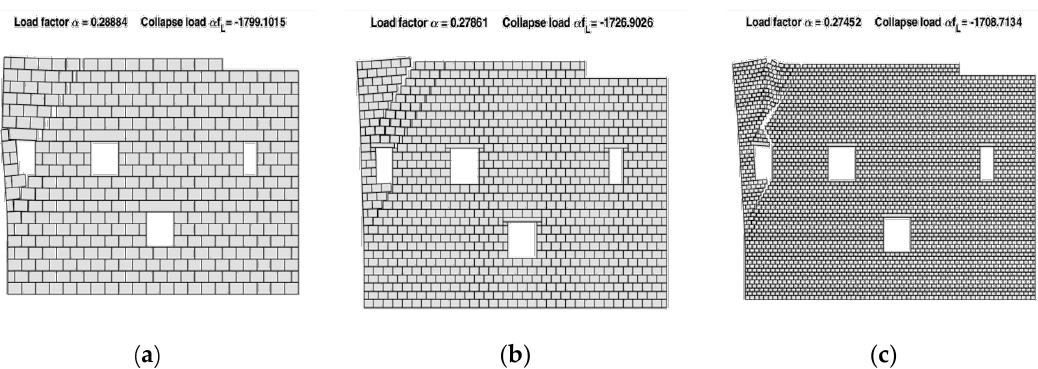
Figure 10. The in-plane collapse mechanisms of the F3 façade for the meshes ( a ) M1, ( b ) M2, and ( c ) M3.